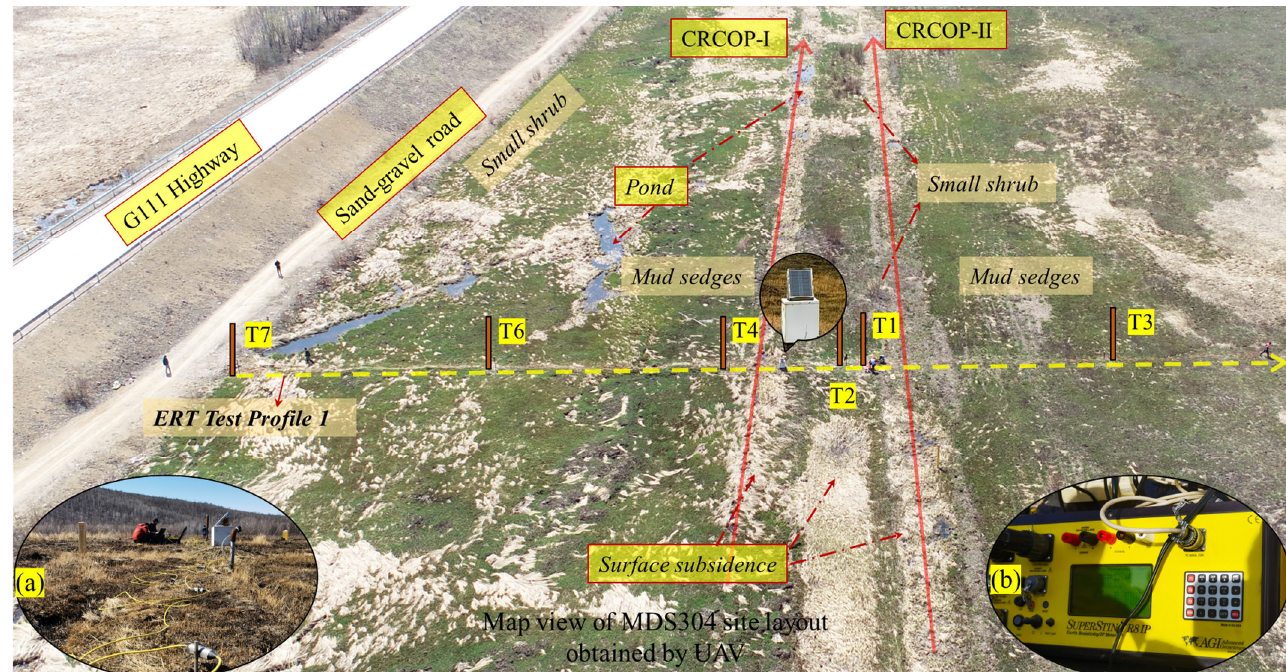
Figure 7. Researchers using the SuperSting R8 Polarization Meter to conduct ERT tests at the MDS304 site in Jinsong town on 18 April 2021 ( a ), and photo of SuperSting R8 Polarization Meter ( b ). This map view image was captured by UVA on 19 May 2022. Note: T1, . . . , T7 is a ground temperature borehole; CRCOP-I: the CRCOP’s first line; CRCOP-II: the CRCOP’s second